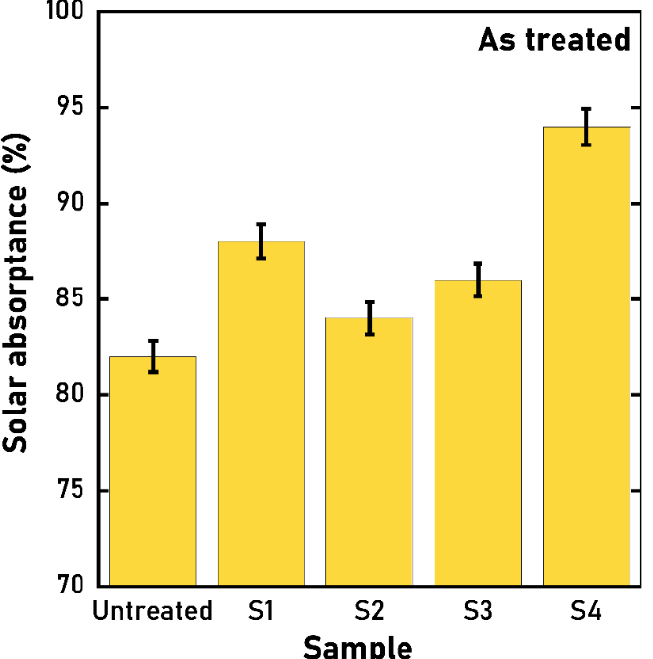
Figure 8. Solar absorptance of the four treated samples and the reference untreated one.